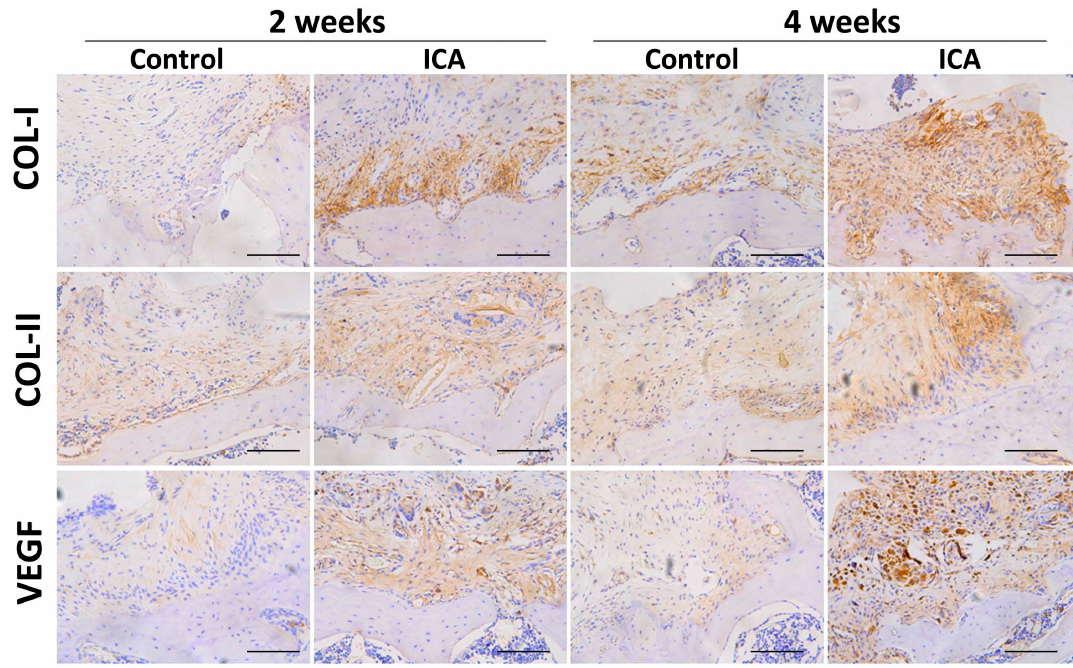
Figure 4. Results of the immunohistochemical staining. ICA treatment significantly increased the expression of type I and type II collagen when compared with the level in the control group at each time point (total magnification, 200×). In addition, more VEGF-positive cells were observed in the ICA group, revealing that ICA may not only improve the formation of collagen, but could also improve angiogenesis, bar = 100 μ m.